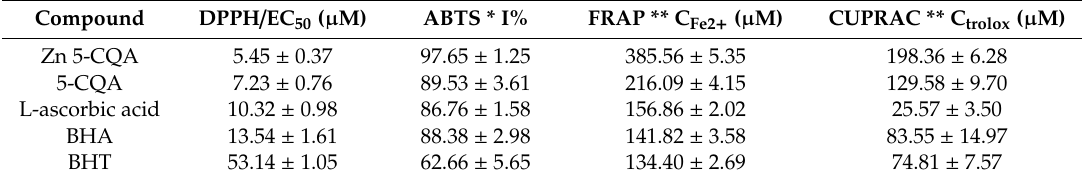
Table 1. Antioxidant properties of the Zn 5-CQA, 5-CQA, L-ascorbic acid, butylated hydroxyanisol (BHA) and butylated hydroxytoluene (BHT) expressed as the ability to scavenge DPPH · radical (EC 50 ) and ABTS · + cation radical as well as FRAP and CUPRAC values (the concentrations of tested substances in the samples were * 25 µ M, ** 50 µ M).